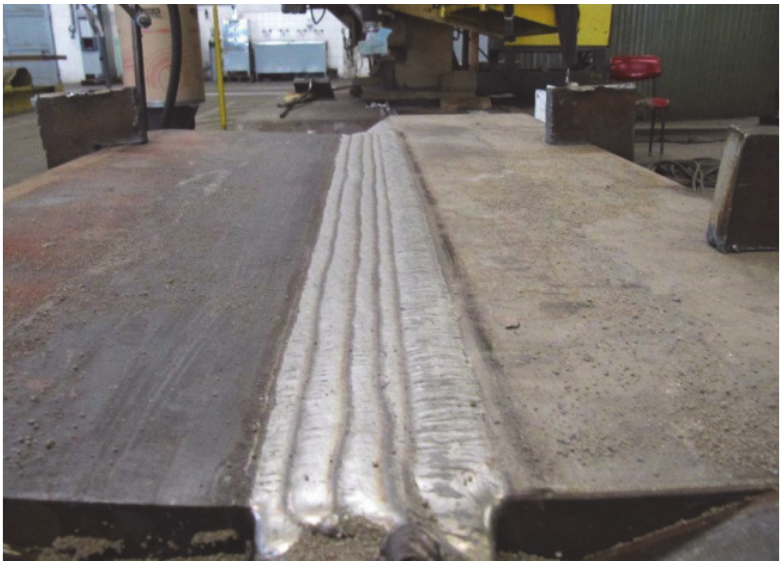
Figure 1: The mock-up.